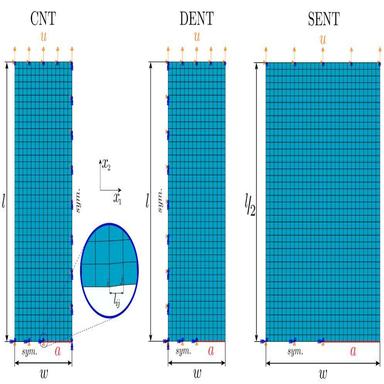
Quarter-specimen (CNT, DENT) and half-specimen (SENT) 2D FE models for calculating κ.